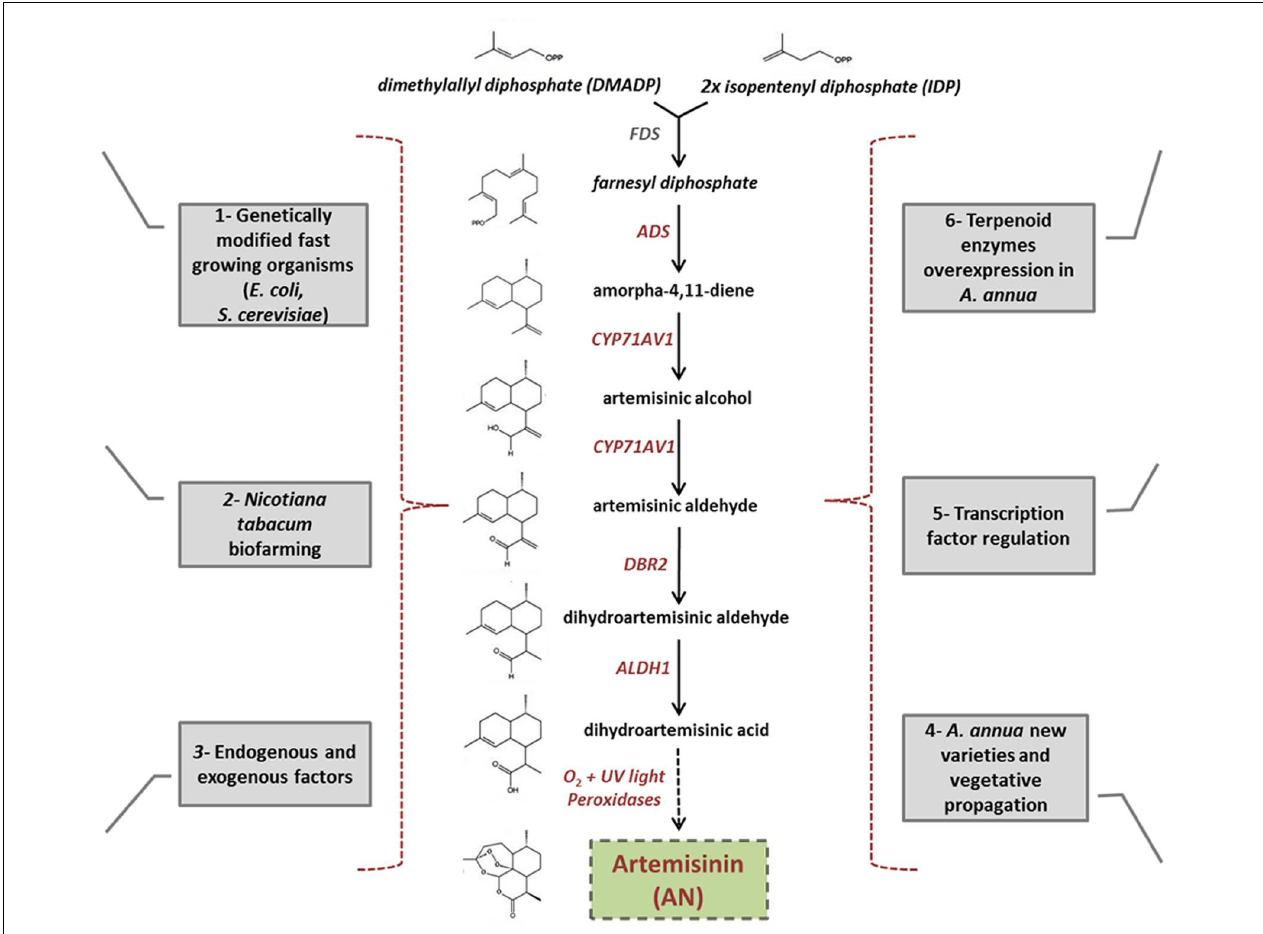
FIGURE 3 | Diagram showing the different biofarming alternatives used instead of AN chemical synthesis. (1) Use of genetically modified, fast growing organisms, such as Escherichia coli and Saccharomyces cerevisiae, for AN production. (2) Nicotiana tabacum used as a model plant for molecular farming. (3) Plant endogenous factors, such as phytohormones and external abiotic factors, positively affect both trichome proliferation and artemisinin biosynthesis. (4) Crop-breeding and vegetative propagation used to obtain tissue with higher AN content (5) Use of transcription factors, that positively regulate artemisinin pathway, as an approach for increasing the amount of this molecule in the plant. (6) Metabolic engineering of overexpressing endogenous enzymes of terpenoid biosynthesis in A. annua. The artemisinin biosynthetic pathway occurs exclusively in the glandular trichomes of A. annua plant. Despite AN biosynthesis utilizes carbon mainly from the mevalonate pathway in the cytosol, Farnesyl diphosphate (FPP), AN precursor, is partially synthetized in the plastid through a non-mevalonate pathway. Therefore, redirection of the mevalonate pathway away from the cytosol, to plastid compartments, such as chloroplasts and mitochondria, may be a novel approach for increasing significantly AN